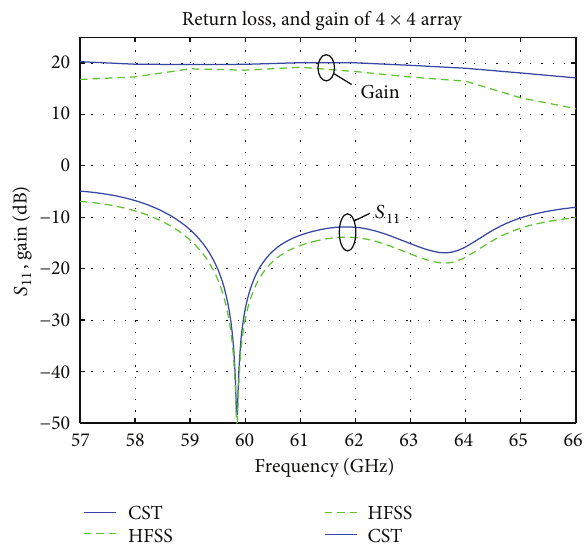
Figure 8: Return loss and gain of 4 × 4 array.